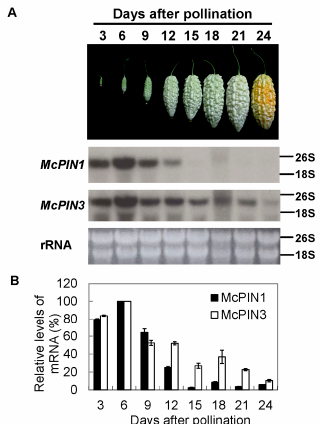
Figure 5. Differential expression of auxin efflux carrier genes during fruit development and ripening of bitter gourd. ( A ) Accumulation of mRNA of auxin efflux carrier genes in bitter gourd during fruit development; ( B ) The expression level in each treatment was normalized to the 26S and 18S loading control; the maximum level was set to 100%, and all other time points were normalized to it. Relative expression was determined in triplicate measurements in three independent biological replicates. Error bars represent the standard deviation.